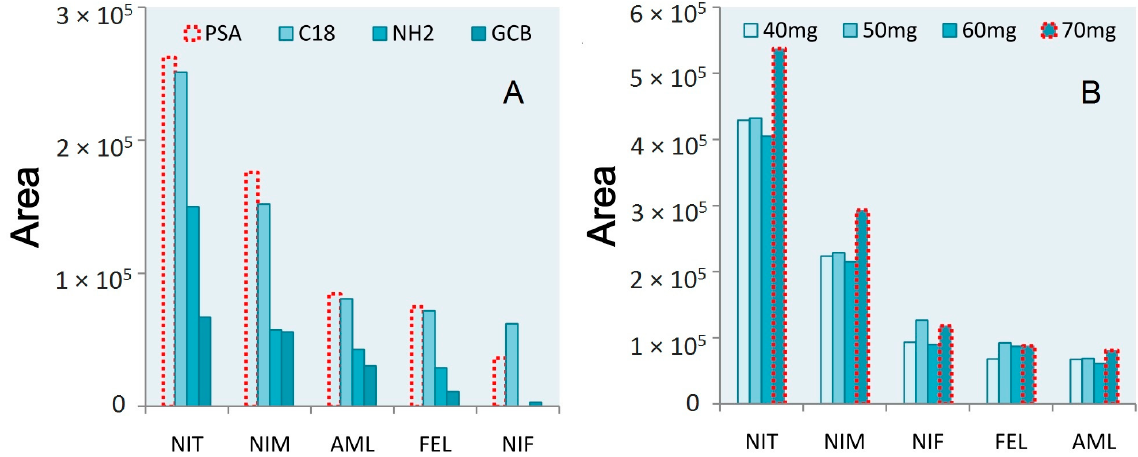
Figure 3. ( A ) The area results of five CCBs treated with different purifying agents. ( B ) The area results of five CCBs treated with different amounts of purifying agents.